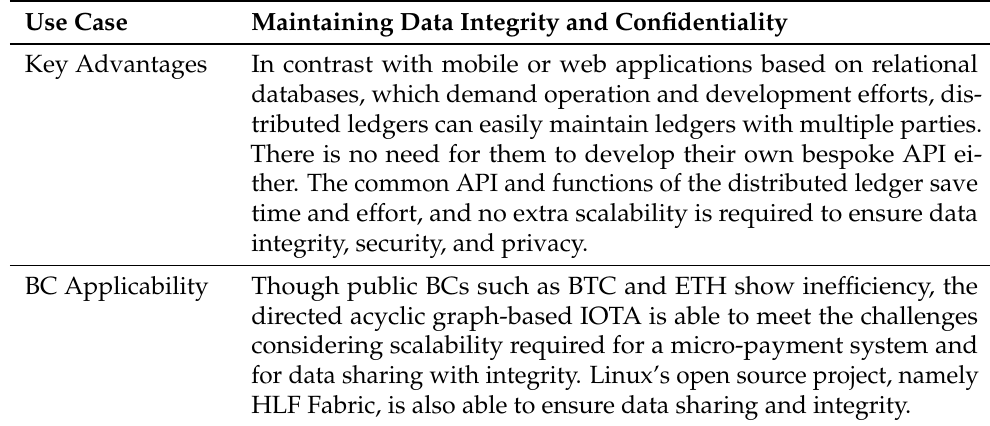
Table 7. Key advantages and BC applicability for the data integrity and confidentiality use